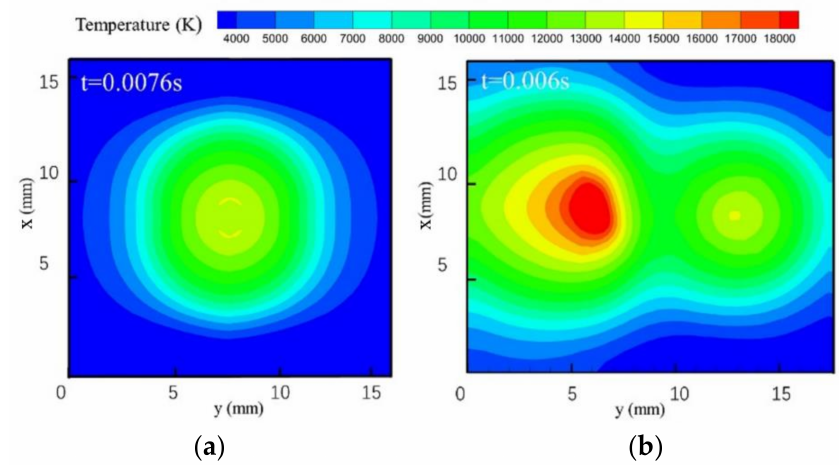
Figure 5. Temperature distribution within the horizontal cross-section at z = 1 mm: ( a ) MIG; ( b )